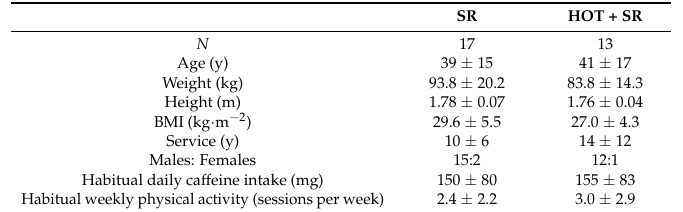
Table 1. Characteristics of firefighters in the SR and HOT + SR